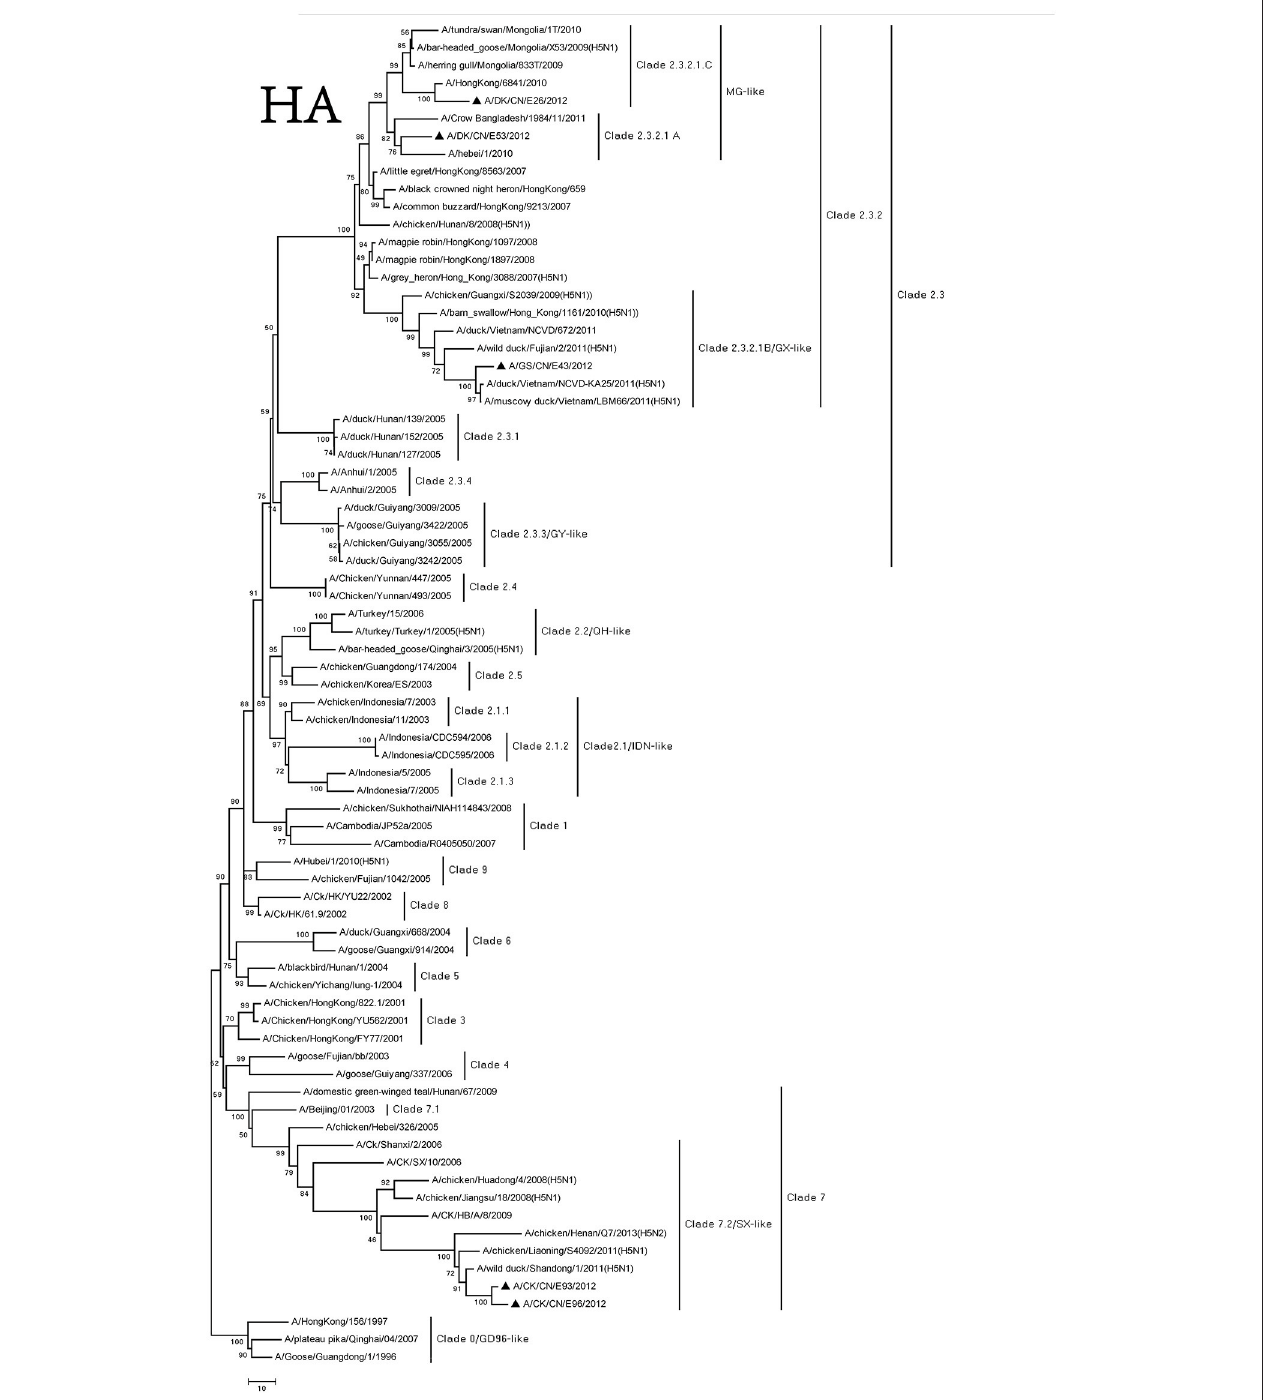
FIGURE 1 | Phylogenetic analysis of HA. HA(A): nucleotides (nt) 29–1,732. Triangles indicate viruses characterized in this study, other virus sequence were downloaded from GenBank. QH, Qinghai; VN, Vietnam; IDN, Indonesia; GY, Guiyang; MG, Mongolia; GX, Guangxi; HD, Huadong; SX, Shanxi.